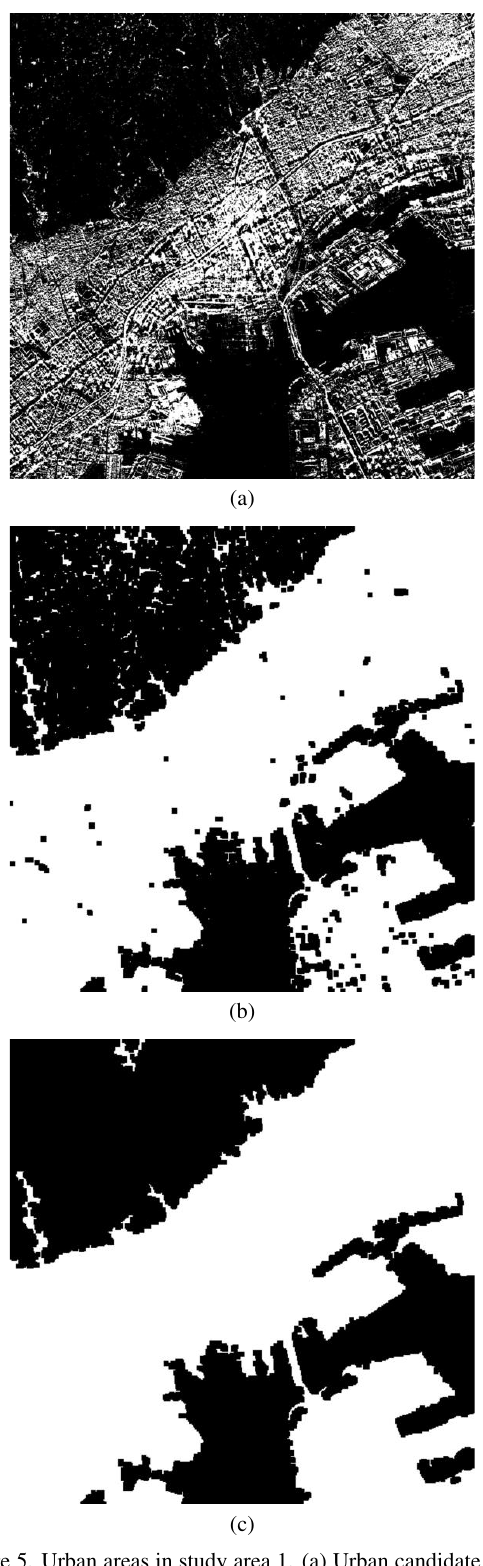
Figure 6. Urban areas in study area 2. (a) Classification result using TP and P v without closing, (b) classification result using (cid:13) HH;V V without closing, and (c) final